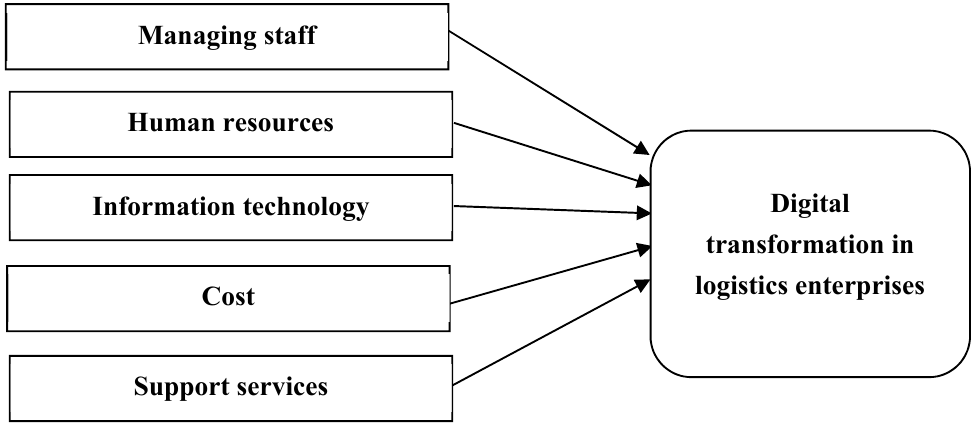
Figure 2. The research model on factors affecting digital transformation in logistics enterprises.